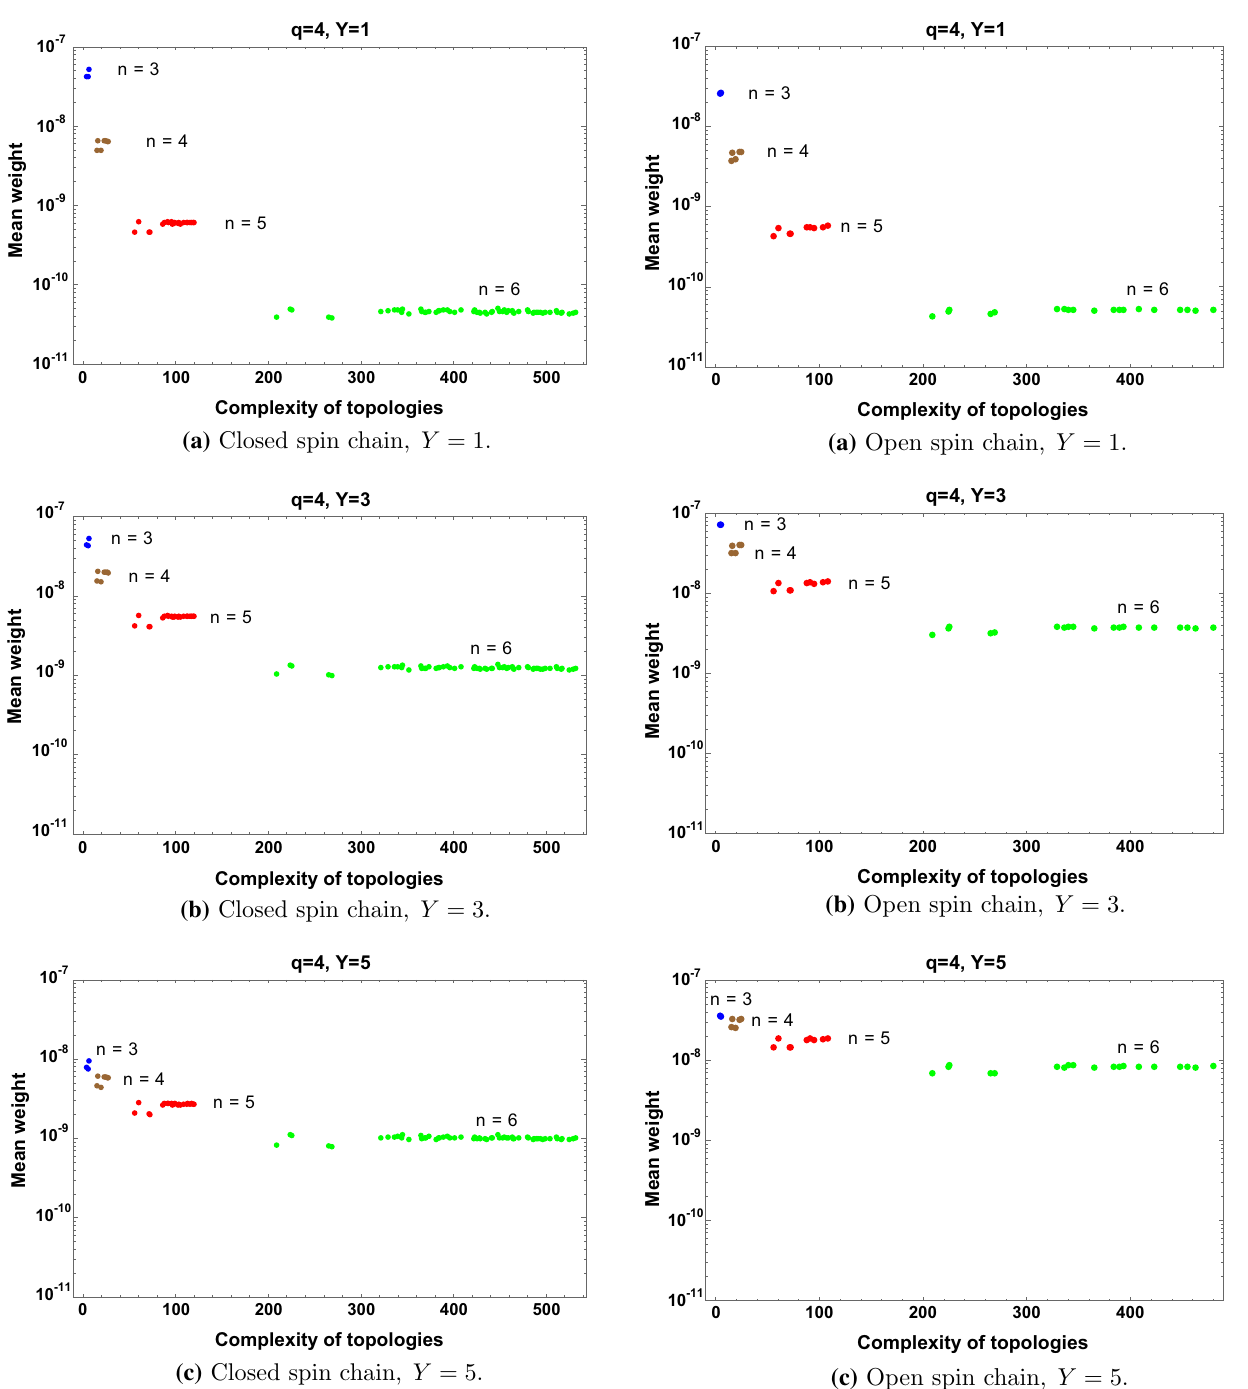
Fig. 12 AverageweightpercomplexityclassforclosedReggeonwebs Fig. 13 Average weight per complexity class for open Reggeon webs As a by-product of our work, we have found an intriguing scaling behavior of what we can call weighted complexity of the Feynman graphs contributing to the gluon Green func- tion. The complexity of a diagram is a well-defined quantity in graph theory. We have evaluated the average weight per topology in the sense of its total contribution to the